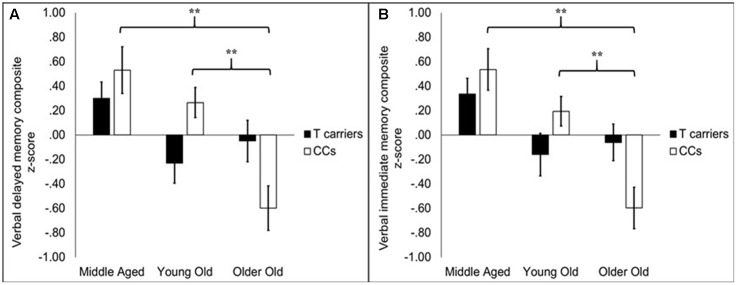
Bar graphs depicting average composite scores on delayed (A) and immediate (B) memory for KIBRA groups broken into age groups. Error bars reflect standard error of the mean. On both measures, performance declined with age group in the CC homozygotes (CCs) but did not significantly decline in the T carriers. In the CC homozygotes, older old participants had significantly lower performance compared to middle aged and young old participants. The latter two groups did not differ. ∗∗p < 0.001.